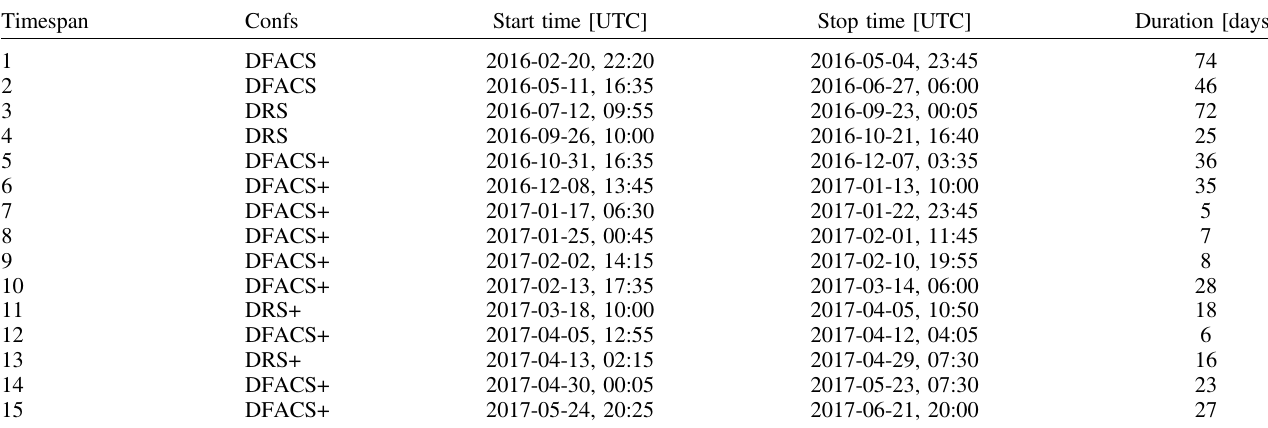
Table 2. LPF electronics con fi guration during different time intervals.